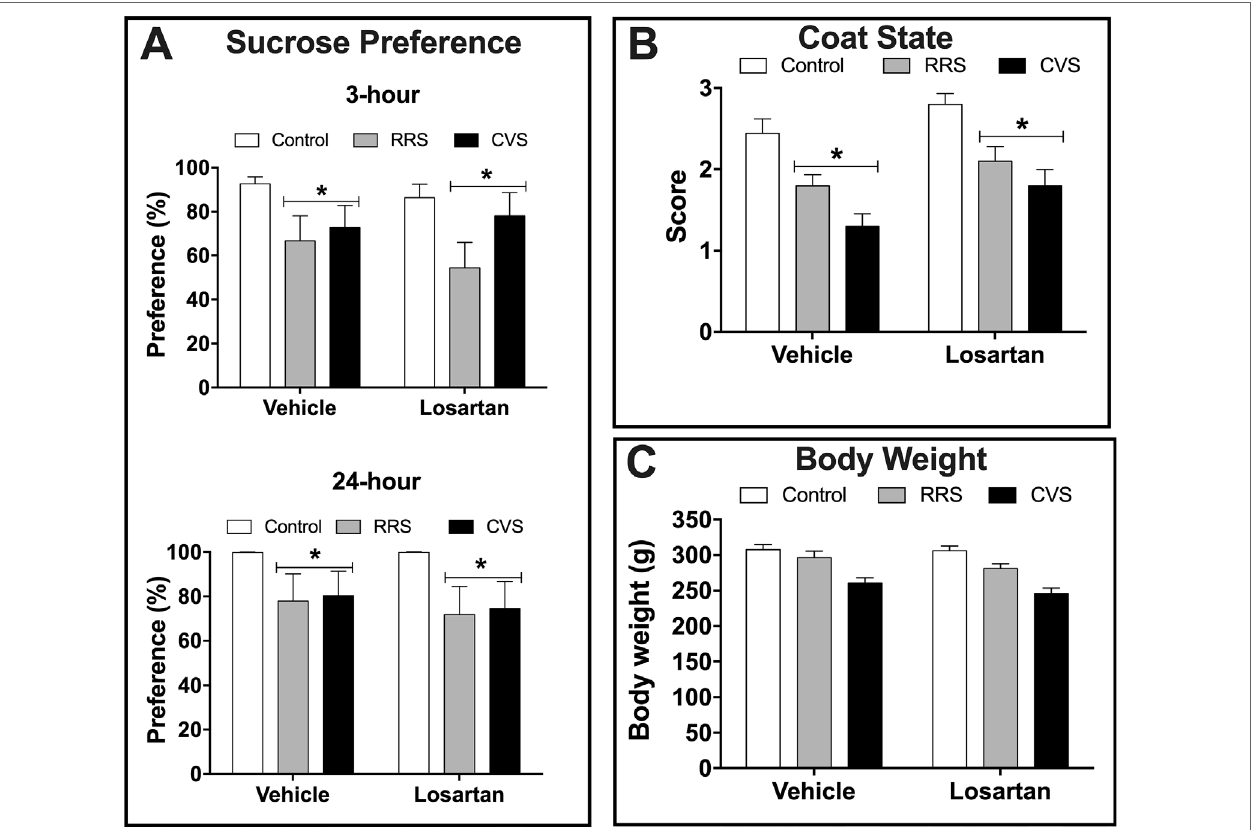
FIGURE 1 | Depressive-like state in animals treated with either vehicle or losartan control (white bars) and subjected to RRS (gray bars) or CVS (black bars). (A) Sucrose preference (%) evaluated during 3 and 24 h. *P < 0.05 versus respective control group, two-way ANOVA (n = 10/group). (B) Coat state score. *P < 0.05 versus respective control group, two-way ANOVA (n = 10/group). (C) Body weight at the 10 th day of stress protocol. Two-way ANOVA (n = 10/group). The bars in all graphs represent the mean ±